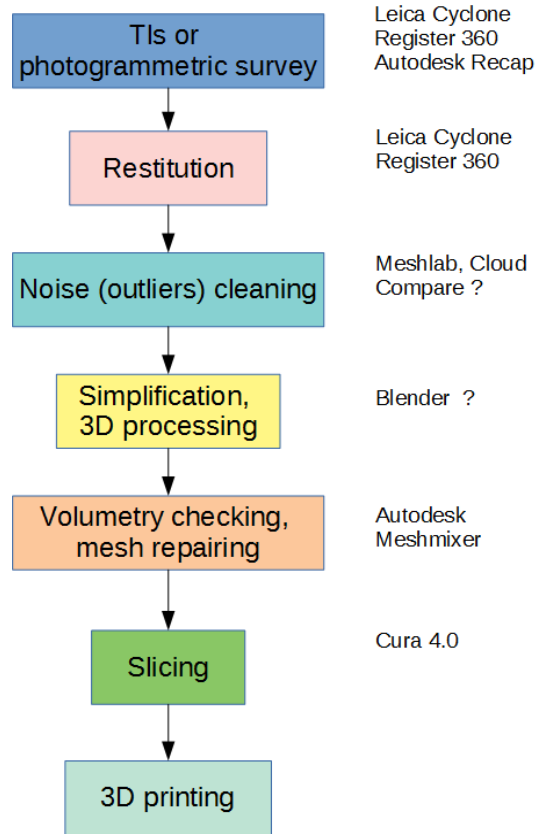
Figure 4. Rapid Prototyping